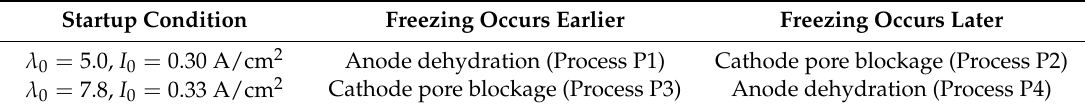
Table 3. The failure modes in the ambiguous zone with startup temperature − 20 ◦